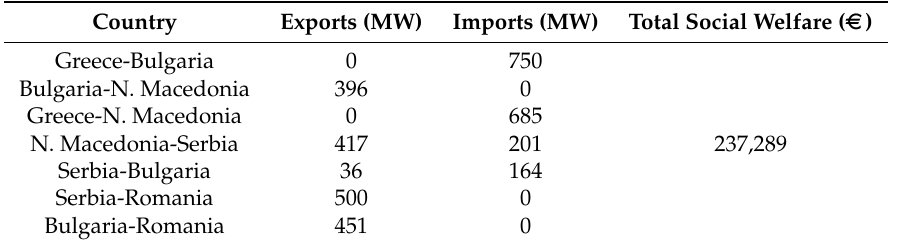
Table 7. Cross-border flows via the ATC method for the 5 country scenario.